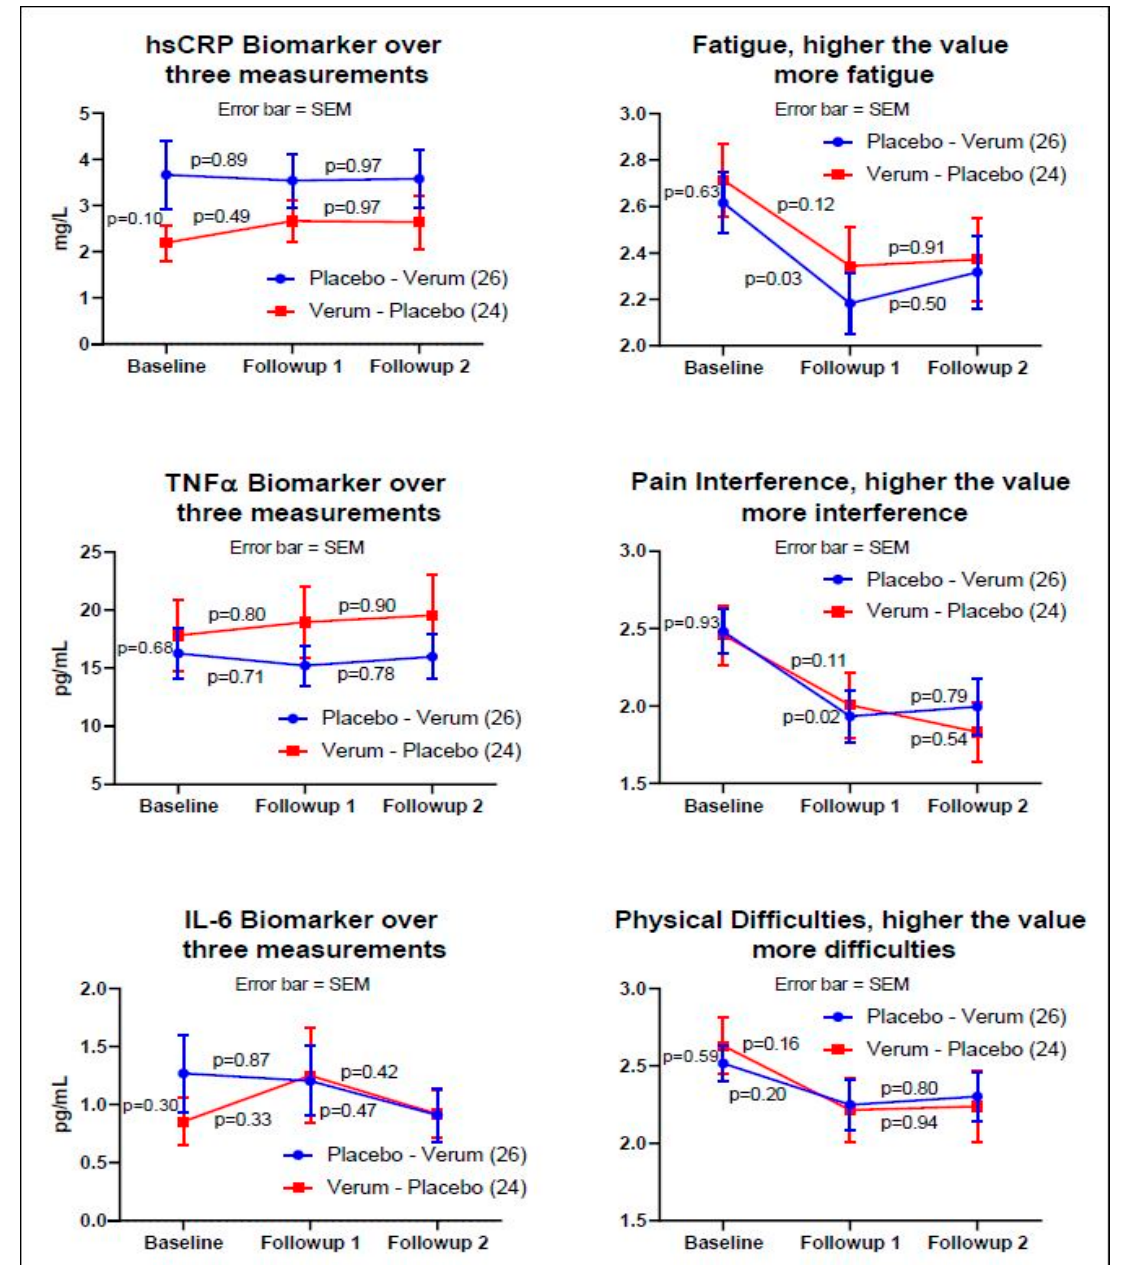
Figure 2. The graphs on the left side are the biomarkers: hsCRP, TNF α , and IL-6. The graphs on the right side are the subjective assessments: PROMIS ® fatigue, pain interference, and physical functioning. The y-axis values on the right side of the subjective assessments are the averages of the raw scores from each validated PROMIS ® measure (fatigue, pain interference, physical function) on a 5-point Likert scale. The blue line indicates Group A, and the red line indicates Group B. The p -values indicate pre-post paired- t tests adjusted by the Fisher’s LSD. Subjective measures demonstrated a reduction in three PROMIS ® measures at the time of entry into the study to the first follow up visit; however, the reduction did not continue for either the placebo or the verum dosing. Statistical significance was shown for the subjective assessment of fatigue and pain interference on the placebo arm only ( p < 0.03, two-tail test, Fisher’s